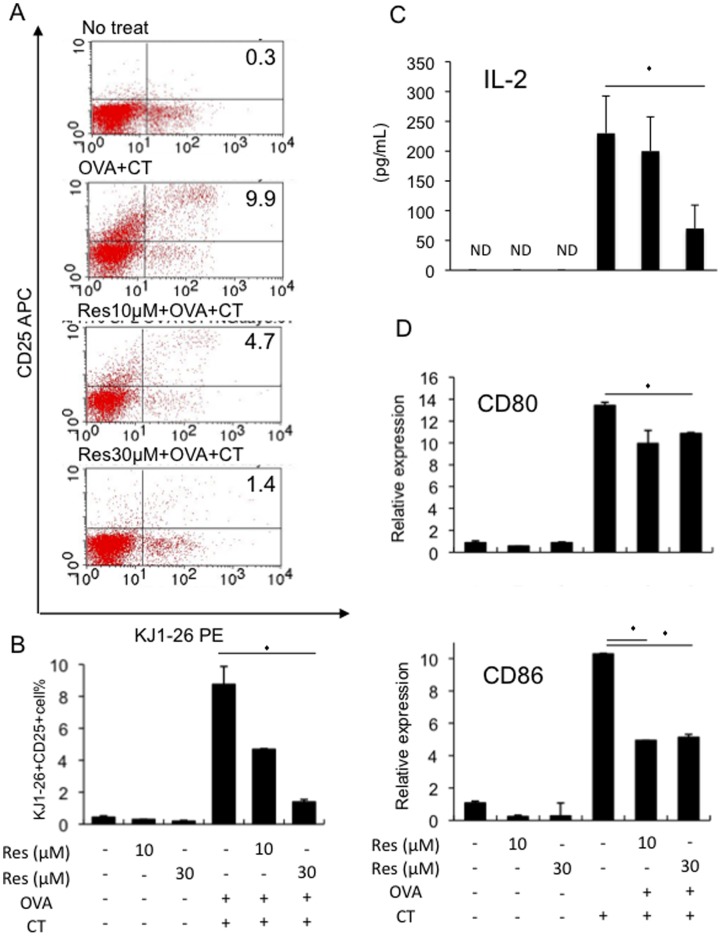
Resveratrol inhibits early T cell activation and co-stimulatory molecule expression in APCs in vitro.DO11.10 mice-derived splenocytes were un-stimulated (no treat) or stimulated with 300 µg/ml OVA plus 12 pM CT and were cultured in the presence or absence of 10 or 30 µM resveratrol for 1 day. Then the analysis described below was performed. A. After 1 day-culture, whole splenocytes were stained with PE-conjugated anti-KJ1–26 and APC-conjugated anti-CD25 antibody. Representative FACS plots are shown. Numbers indicate the proportion of the KJ1–26+ CD25+ cells. B. Quantitative analysis of A (n = 3 per group). C. After 1 day-culture, the supernatants were collected and IL-2 concentrations were measured by ELISA (n = 9 per group). D. After 1 day-culture, RNA samples were extracted from the splenocytes and the cDNA samples were synthesized using reverse transcriptase system. Quantitative real-time PCR analysis was then performed to assess CD80 and CD86 mRNA levels. Relative expression levels are shown (n = 3 per group). Values represent the mean ± SD. *P<0.05 in comparison to the corresponding controls. (ND: non-detected).